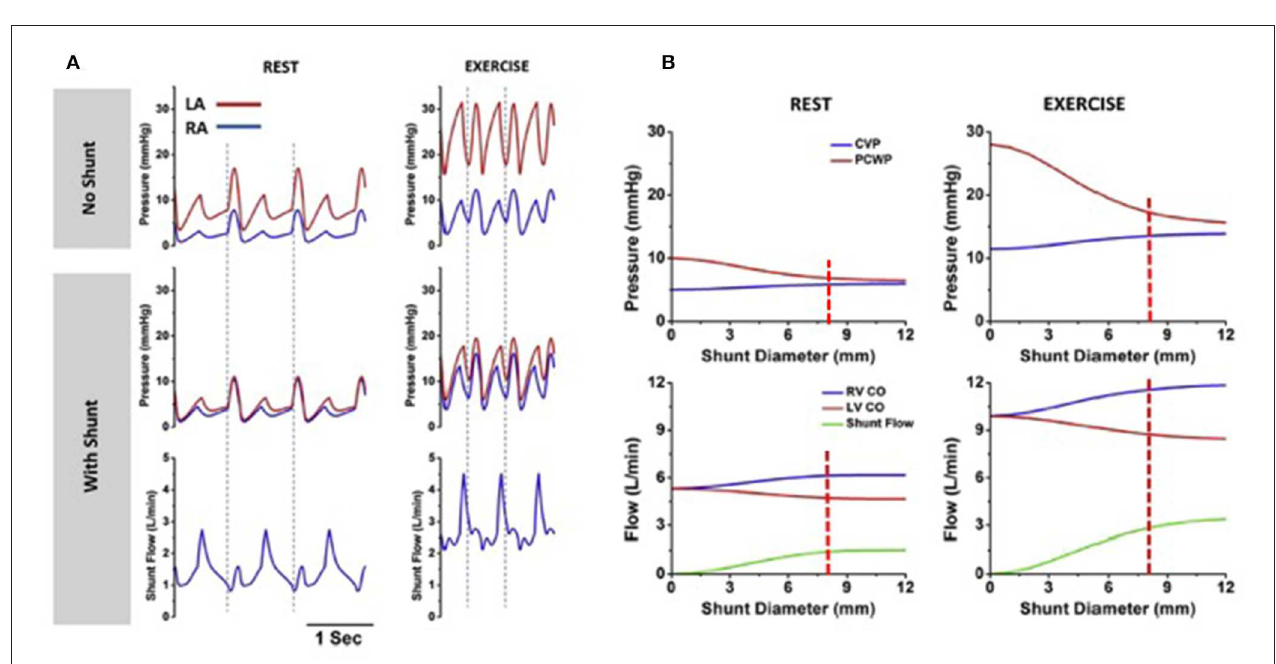
FIGURE 3 | Computer simulations, based on clinical data, show rest and exercise left and right atrial pressures in the absence and presence of the interatrial shunt device (left panel). Right panel shows the influence of shunt diameter on the pressure reduction and amount of left to right shunting (Permission for re-use obtained from Elsevier). (A) Corvia IASD device ex vivo . (B) IASD device in vivo (porcine heart).